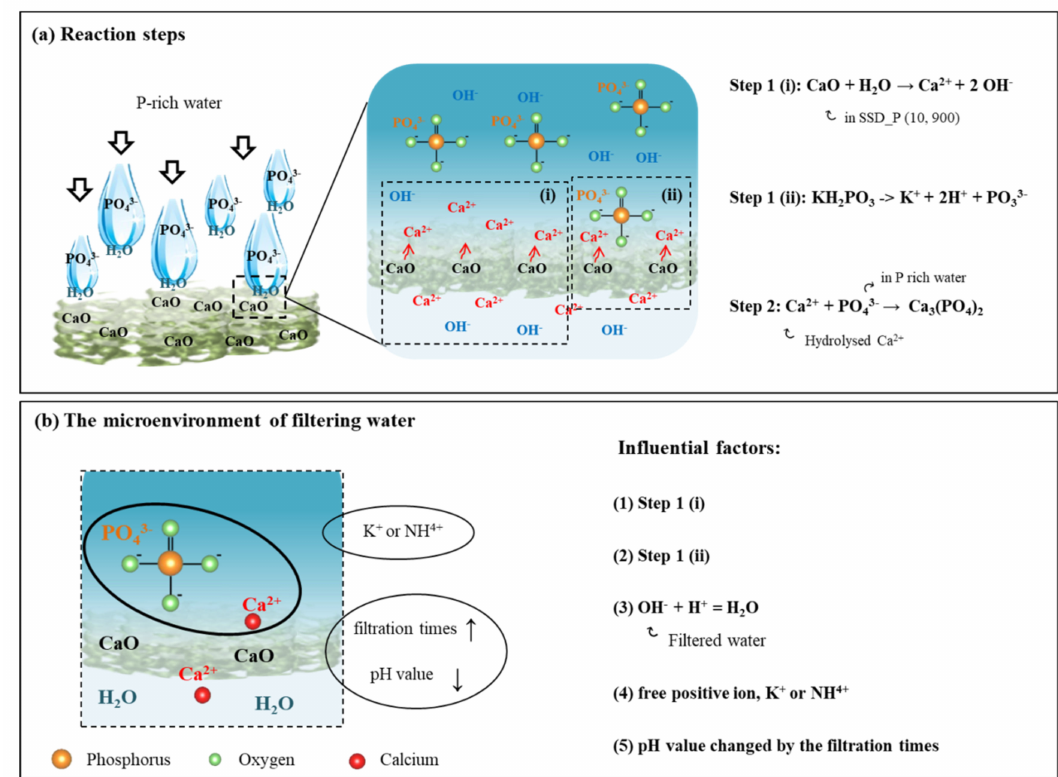
Figure 6. ( a ) The reaction mechanism for the release of Ca 2+ and PO 43- (step 1), and the precipitation of Ca 3 (PO 4 ) 2 (step 2) is illustrated. ( b ) The influential factors for the microenvironment of water that alters the filtration performances are